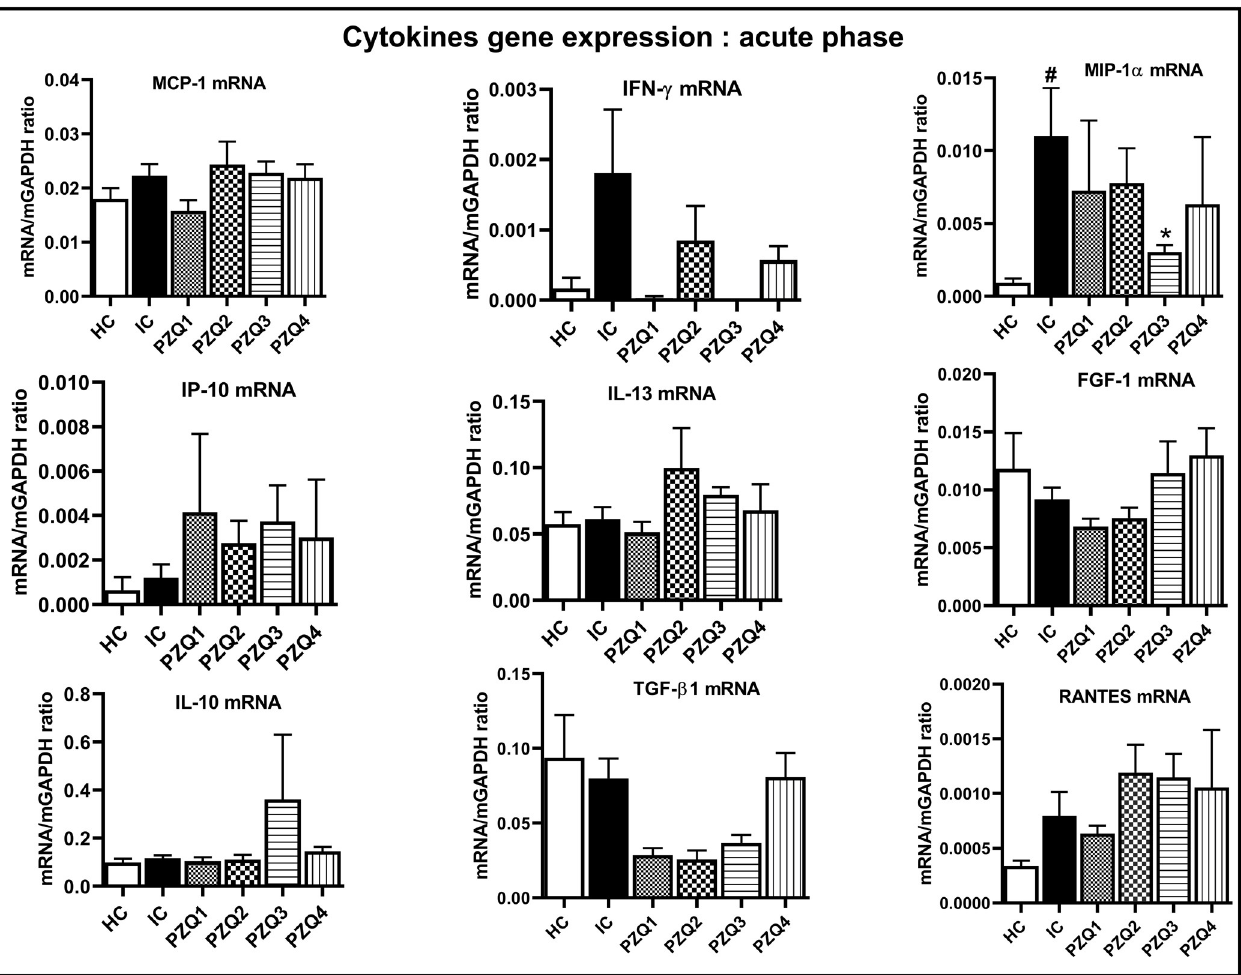
Fig 12. Effect of praziquantel treatment on the liver mRNA expression of cytokines and chemokines during the acute stage of Schistosoma mansoni infection in mice. HC: Uninfected mice, IC: Infected-untreated mice, PZQ1: Infected mice treated with praziquantel at 100 mg/kg for 5 consecutive days, PZQ2: Infected mice treated with praziquantel at 100 mg/kg for 28 consecutive days, PZQ3: Infected mice treated with praziquantel at 18 mg/kg for 28 consecutive days, PZQ4: Infected mice treated with a single dose of praziquantel at 500 mg/kg. Data are expressed as mean ± SEM (n = 6). ANOVA followed by Tukey multiple comparison test was also used for statistical analysis. # p < 0.05: values are significantly different from those uninfected mice (group HC). � p < 0.05: values are significantly different from those of infected-untreated mice (group IC).